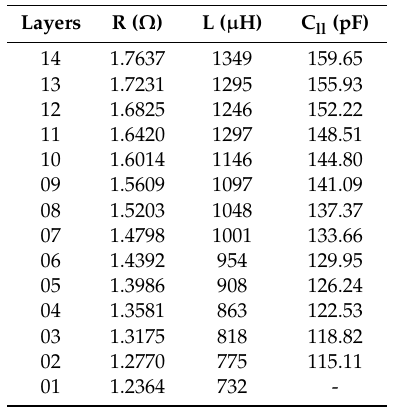
Figure 12. ( a ) Transformer equivalent circuit with 14 HV layers in the winding and lumped LV winding; ( b ) Schematic diagram from layer 1 to layer 12 of HV winding in the subsystem. Table 5. RLC parameters of the HV winding.